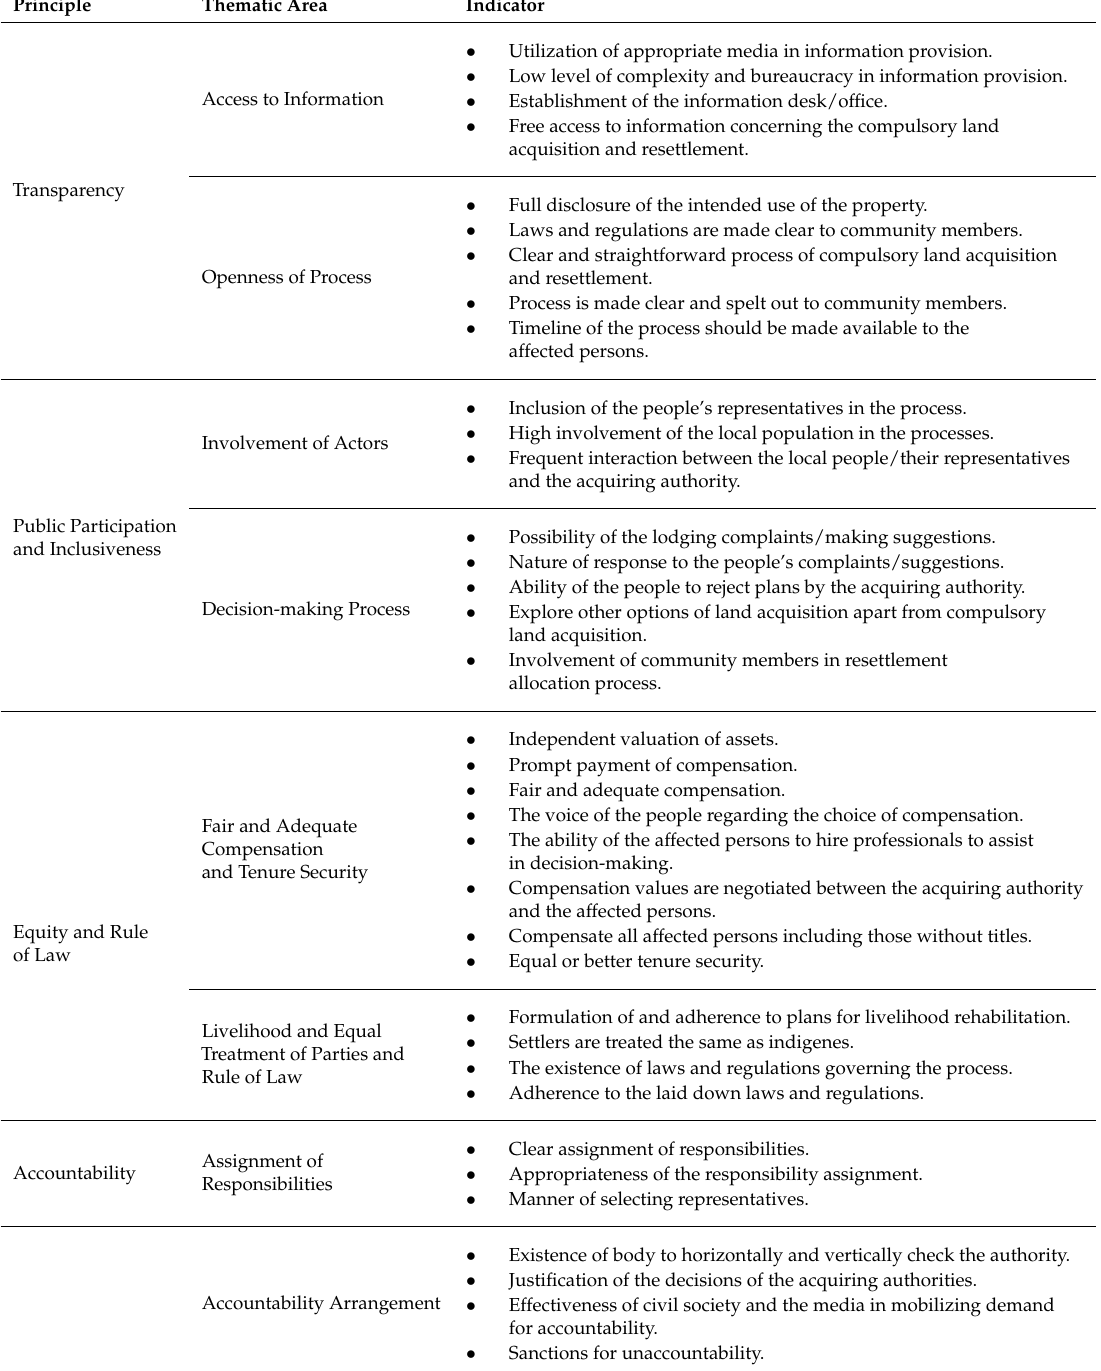
Table 1. Breakdown of good governance assessment framework for